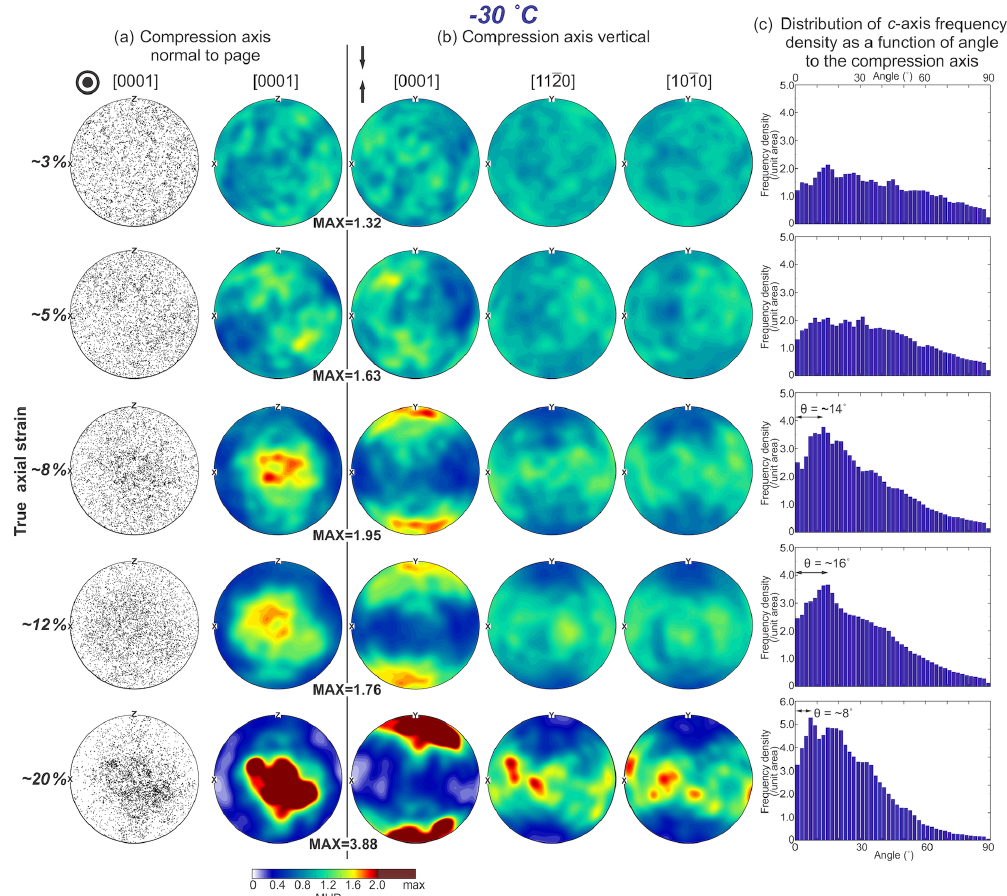
Figure 10. Crystallographic preferred orientations (CPOs) from EBSD data with 30µm step size for ice samples deformed at − 30 ◦ C. Explanation of annotations and the descriptions of sections (a) to (c) are the same as in Fig.